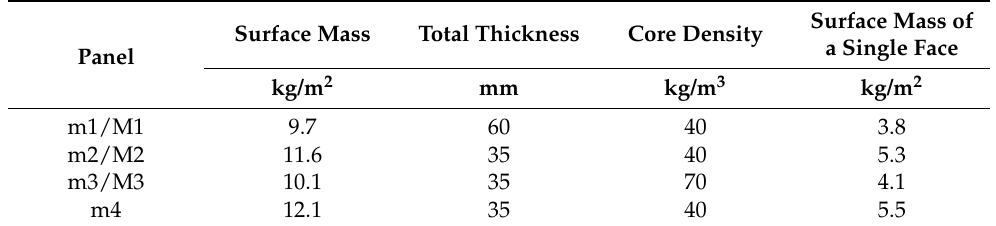
Table 1. The technical characteristics of composite panels include small samples (m1, m2, m3, m4) and full-scale models (M1, M2,